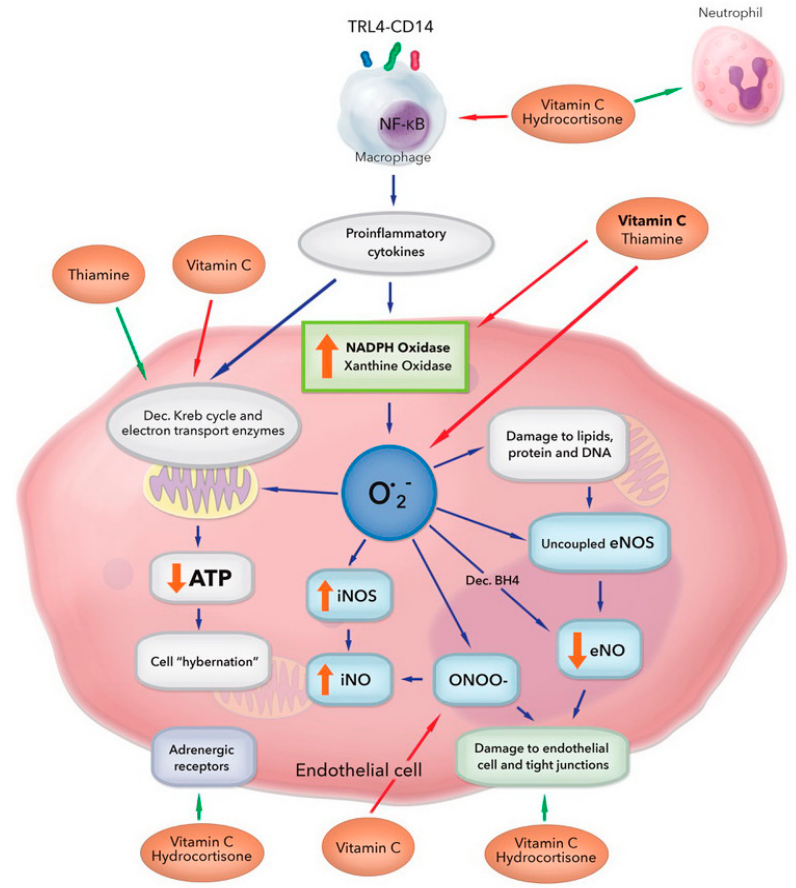
Figure 1. Multiple and overlapping effects of hydrocortisone, vitamin C, and thiamine in the setting of bacterial sepsis. Vitamin C and thiamine scavenge free radicals from superoxide (O 2 − ) and inhibit activation of xanthine oxidase and NADPH oxidase. Vitamin C protects the mitochondria from oxidative stress caused by increased leakage of electrons from the dysfunctional electron transport chain and recovers tetrahydrobiopterin (BH4) from dihydrobiopterin (BH2), restoring endothelial nitric oxide synthase (eNOS) activity and increasing eNO bioavailability. Vitamin C inhibits inducible NOS (iNOS) activation, preventing profuse iNO production and peroxynitrite (ONOO − ) generation. Vitamin C scavenges ONOO − , preventing loosening of the tight junctions of the endothelium. Vitamin C and hydrocortisone decrease the activation of nuclear factor κ B (NF- κ B), thereby decreasing the release of proinflammatory mediators. They restore endothelial tight junctions and increase adrenergic receptor function. Thiamine increases the activity of pyruvate dehydrogenase and alpha ketoglutarate dehydrogenase. These actions act in concert to restore cellular adenosine tri-phosphate (ATP) levels. ↑ —increased levels/activity; ↓ —decreased levels/activity. Figure adapted from Spoelstra-de Man et al.